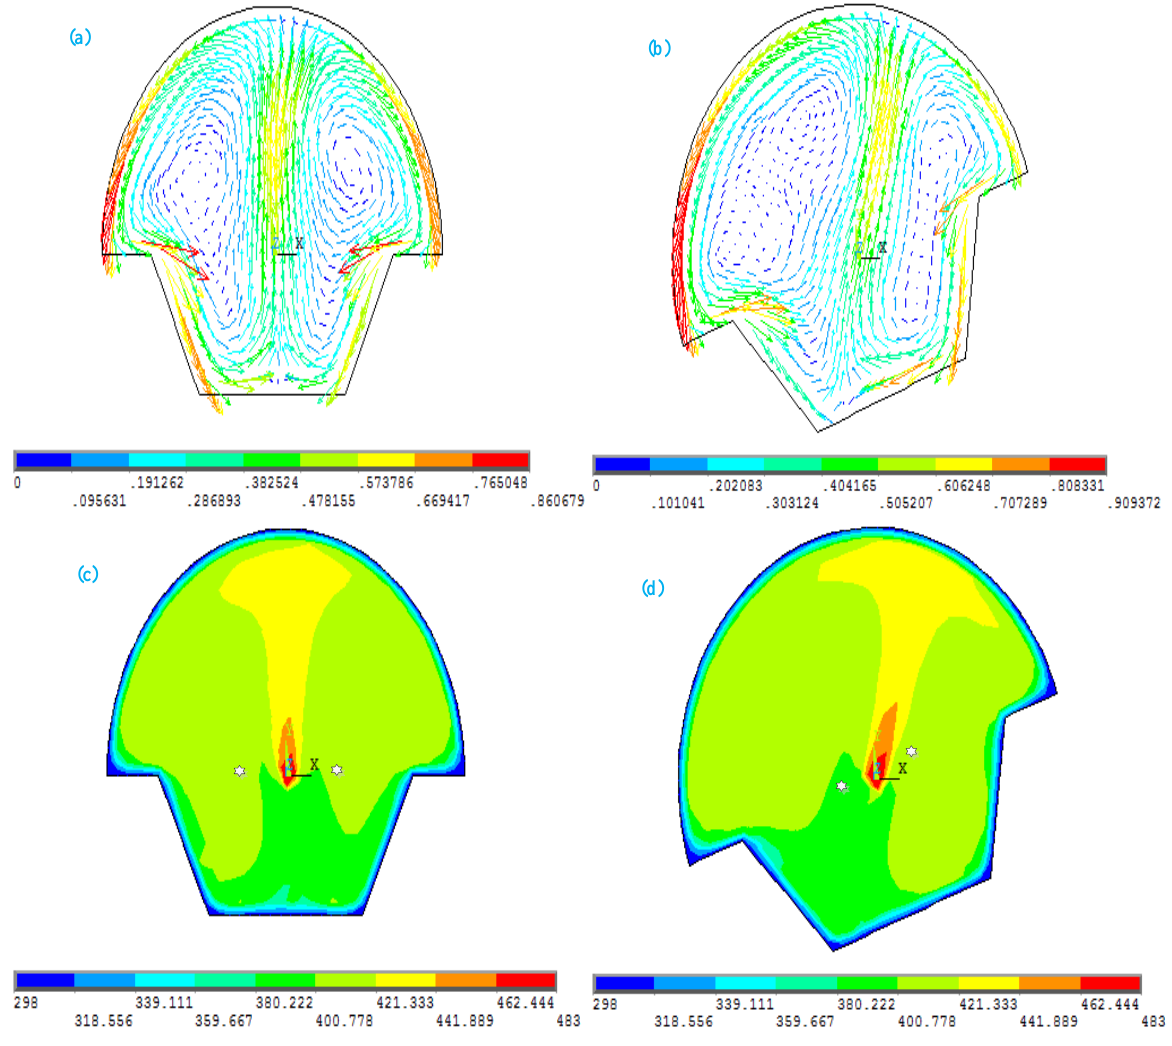
Figure 6. Simulation results for the velocity vector of natural gas convection: ( a ) the direction of gas convection in the horizontal state; ( b ) the direction of gas convection in a tilting state; ( c ) the temperature fields within the chamber in the horizontal state; ( d ) the temperature fields within the chamber in the tilting state (the ambient temperature is set as 298